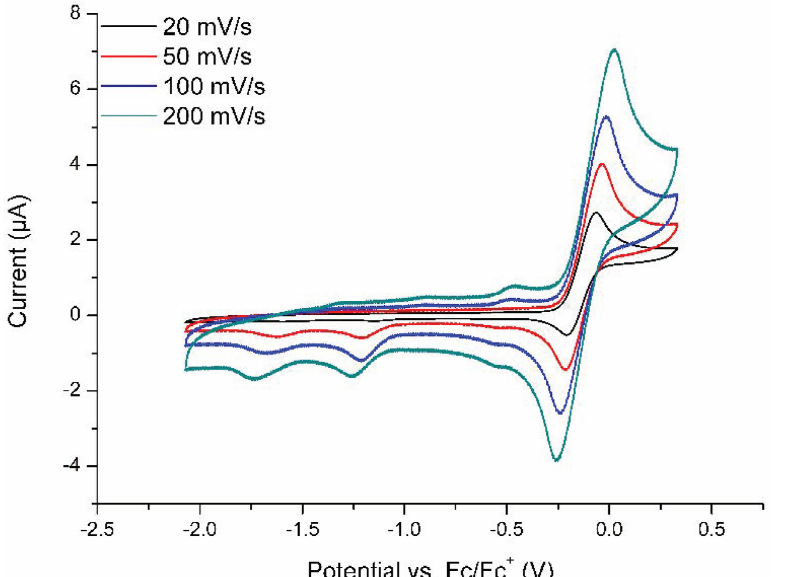
Figure 5. Cyclic voltammograms of 3 in CH 3 CN using 0.1 M nBu 4 NPF 6 as supporting electrolyte at different scan rates under an argon atmosphere measured at room